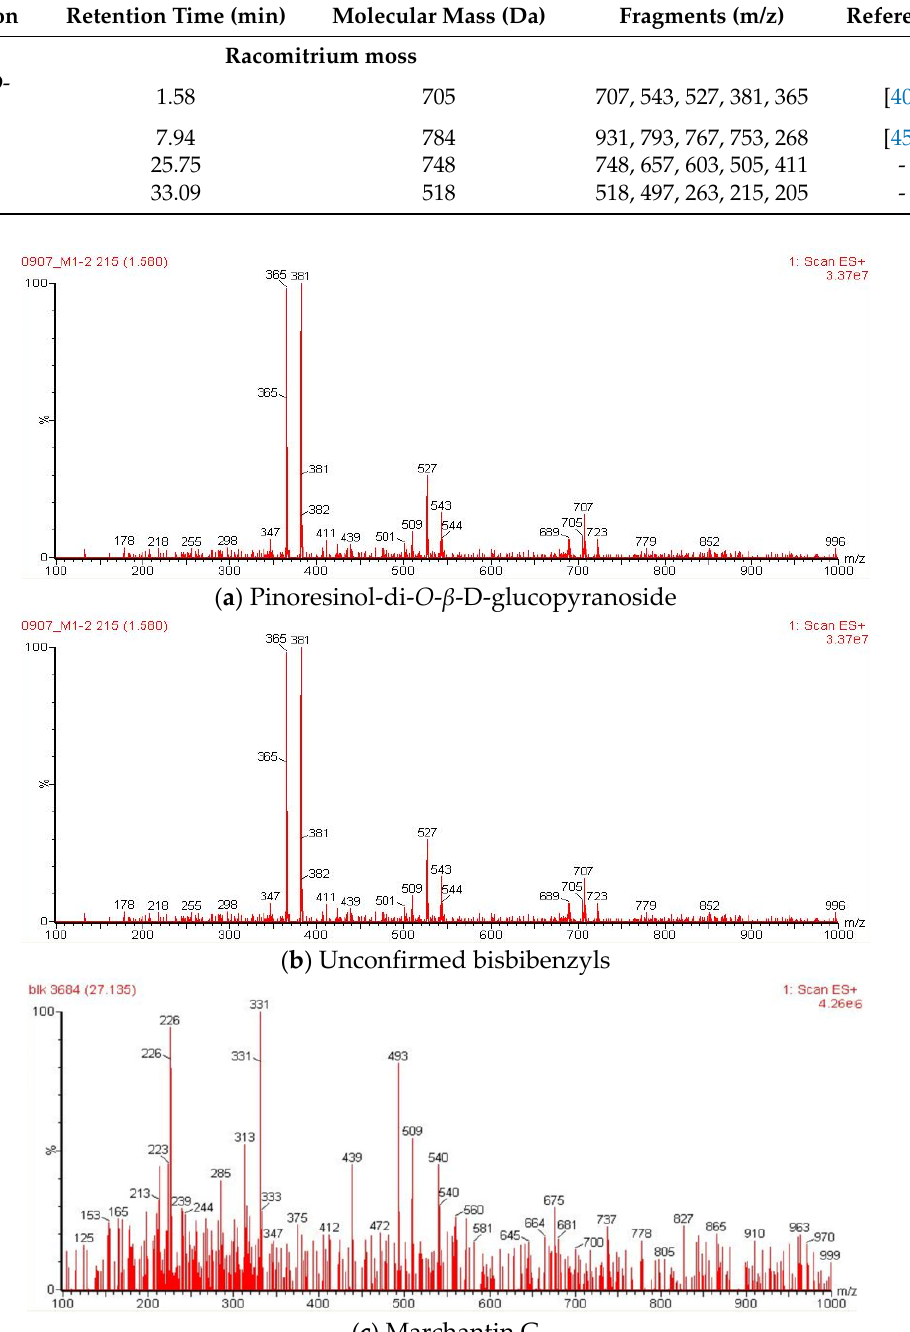
Figure 11. Mass spectra of Pinoresinol-di- O - β -D-glucopyranoside, unconfirmed bisbibenzyl, and marchantin G from the methanol extract of liverwort.